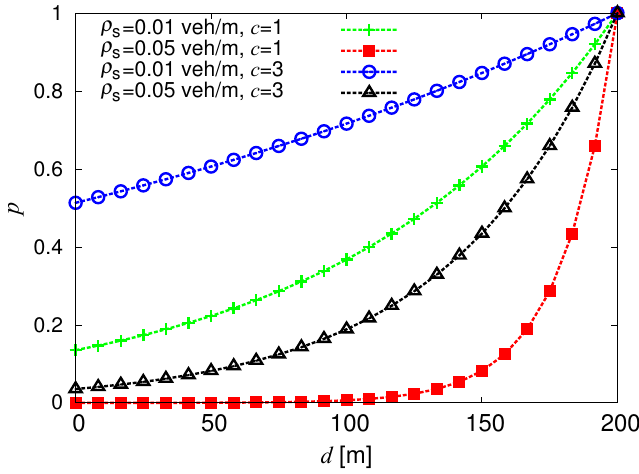
Figure 3. Rebroadcast probability, as a function of the distance, with z = 200 m, c ∈ { 1 , 3 } z ∈ { 0 . 01 , 0 . 05 } and ρ s